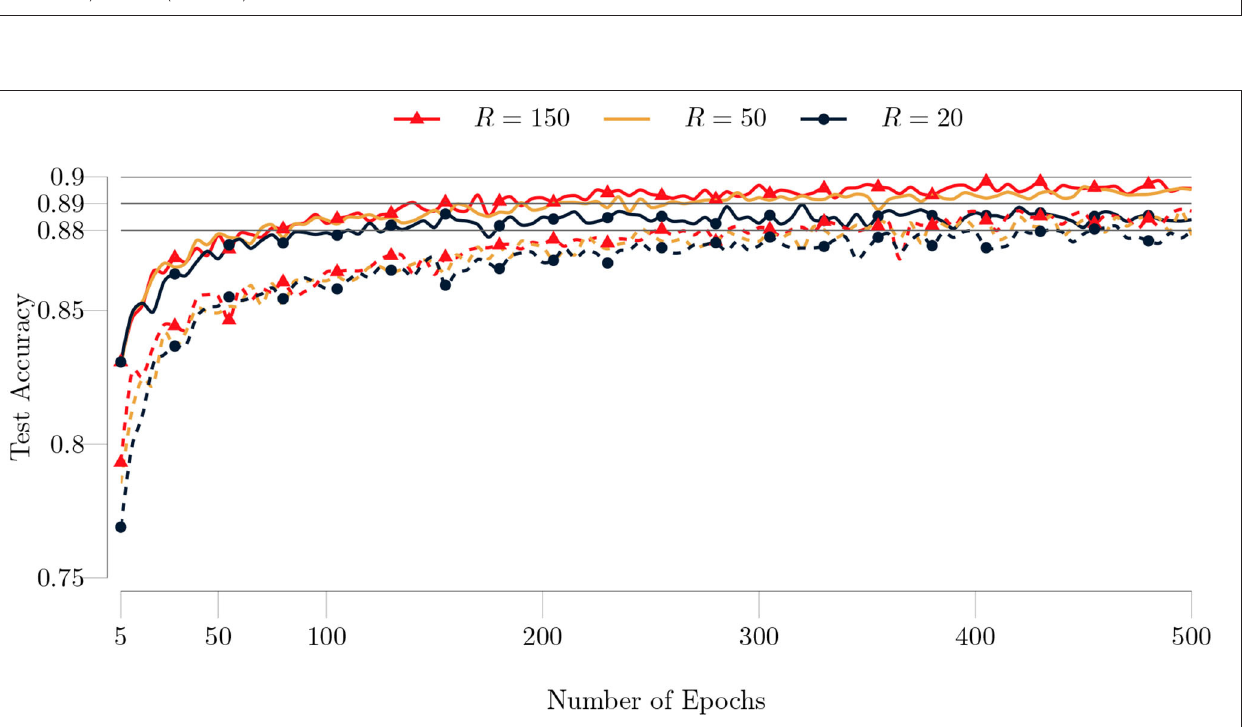
FIGURE 11 | Comparison of test accuracies of the type I model on the MNIST dataset for different maximum number of GN iterations as a function of the number of epochs. The full training set (60,000 images) and test set (10,000 images) are used. The batch size is set to 100 and the maximum number of GN iterations is set to 1 (dashed lines) and to 5 (solid lines).